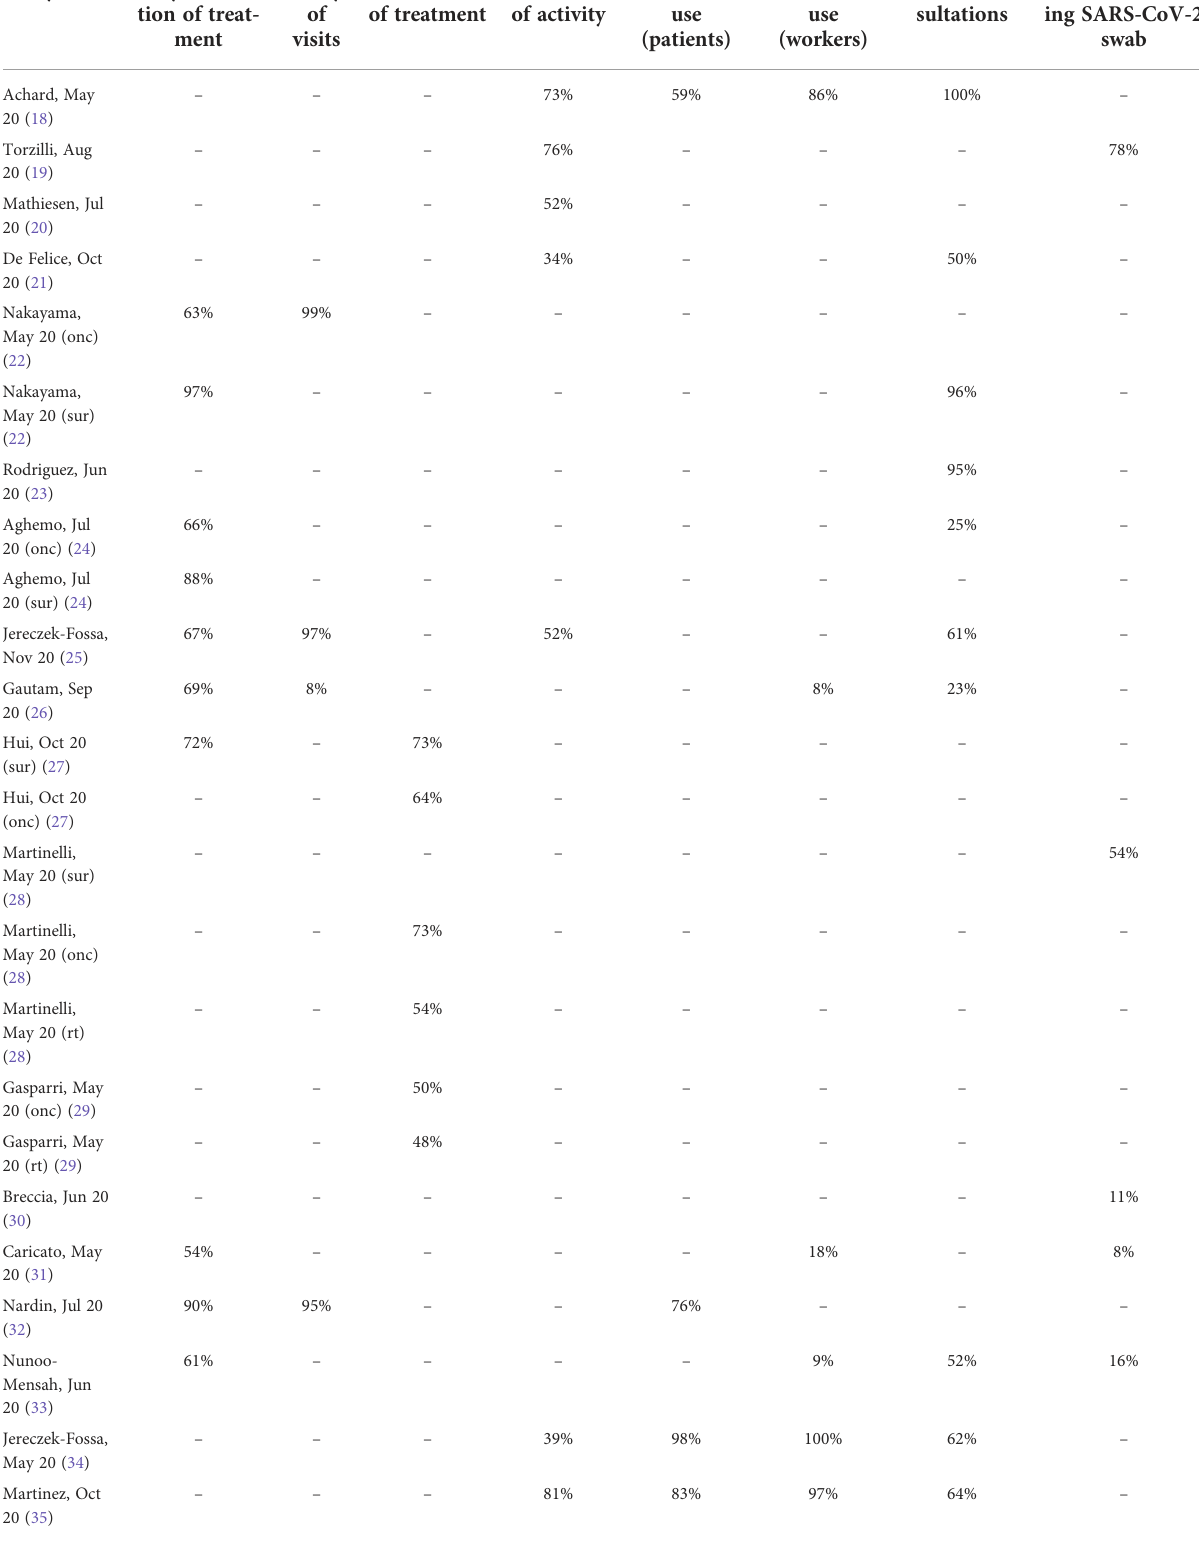
TABLE 2 Summary of the fi ndings of the studies included in the meta-analysis. Rt, radiotherapy; sur, surgery; onc,